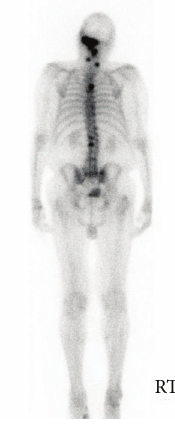
Figure 5: Nuclear medicine bone scan, using technetium 99m- MDP, posterior view; it shows intense radiotracer uptake in the left temporal bone and focal radiotracer localization in the upper thoracic